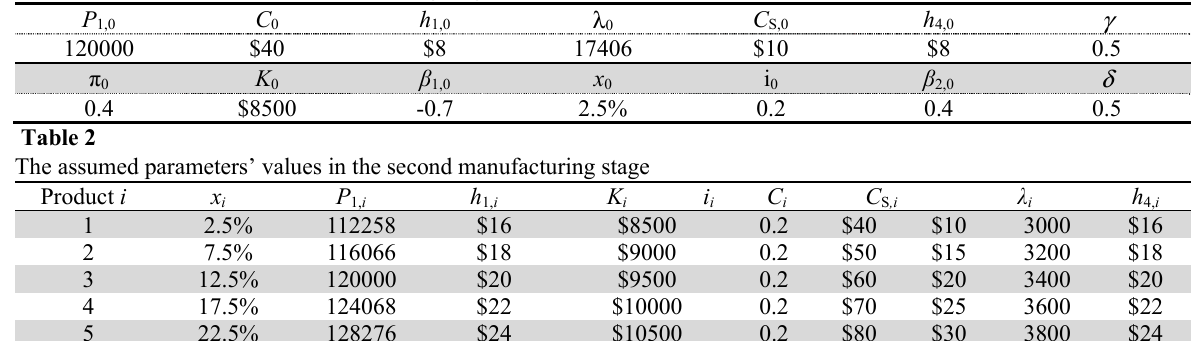
Parameters’ values in the first manufacturing stage